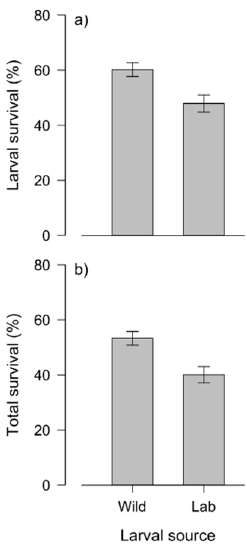
Figure 2. Influence of larval source on mean ( ± SE) survival of second-instar eastern spruce budworm ( a ) to pupation (i.e., larval survival) and ( b ) to adult emergence (total survival) on white spruce trees. Second instars were obtained from a wild population (Wild) or from a laboratory colony (Lab). n = 14 control and 14 endophyte trees.